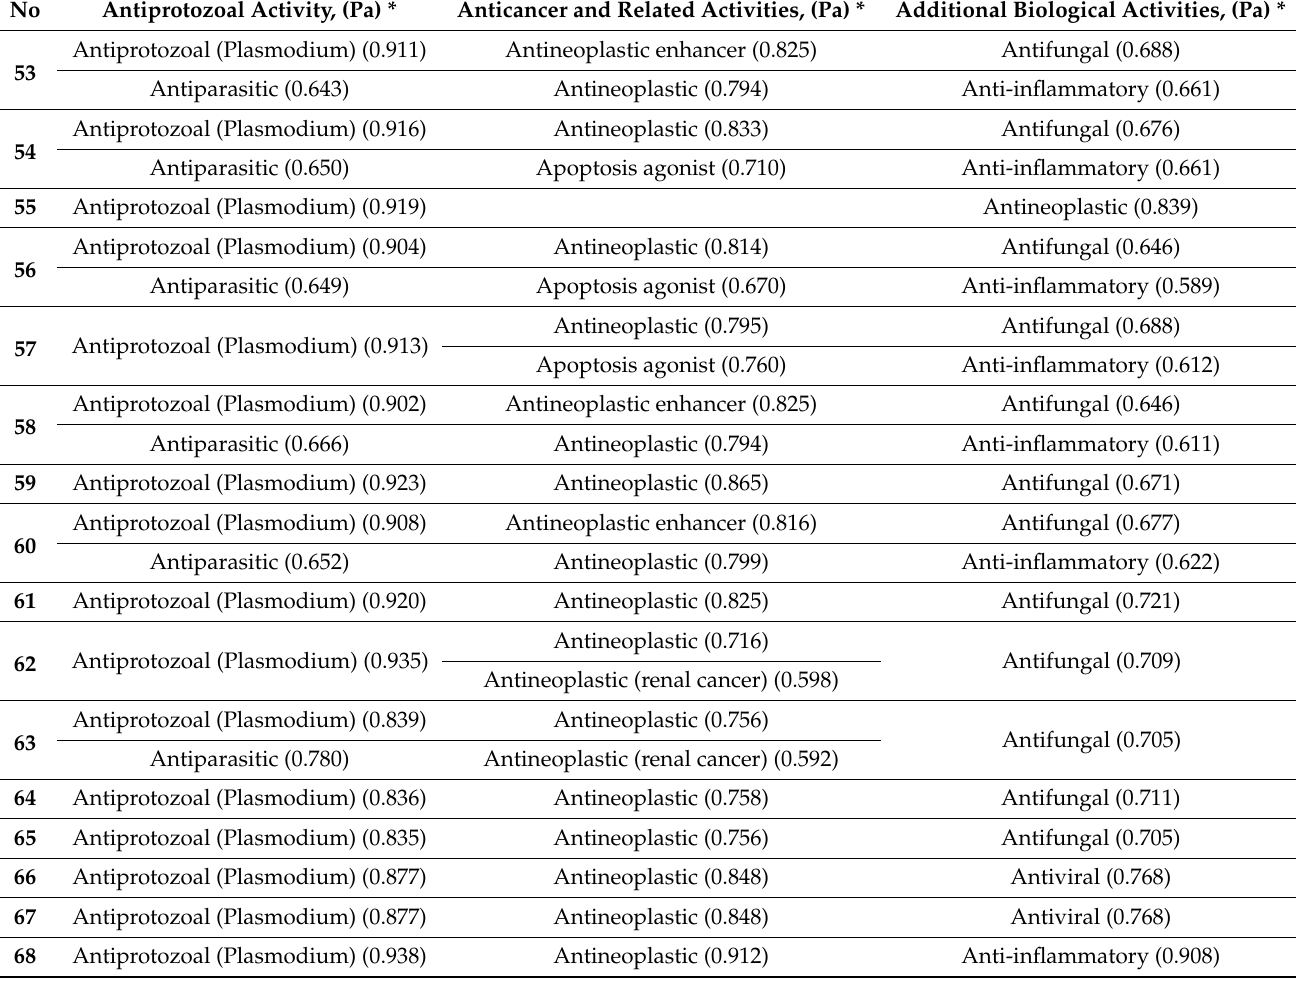
Table 4. Bioactivity of natural polycyclic peroxides derived from fungi and fungal